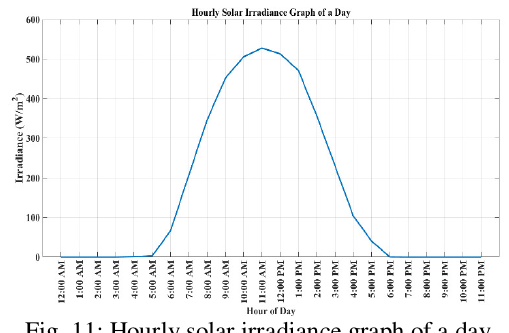
Fig. 11: Hourly solar irradiance graph of a day